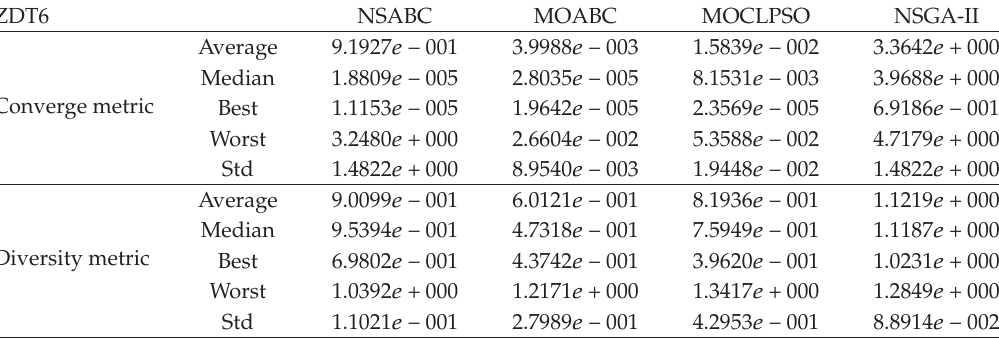
Table 13: Comparison of performance on ZDT6 after 10000